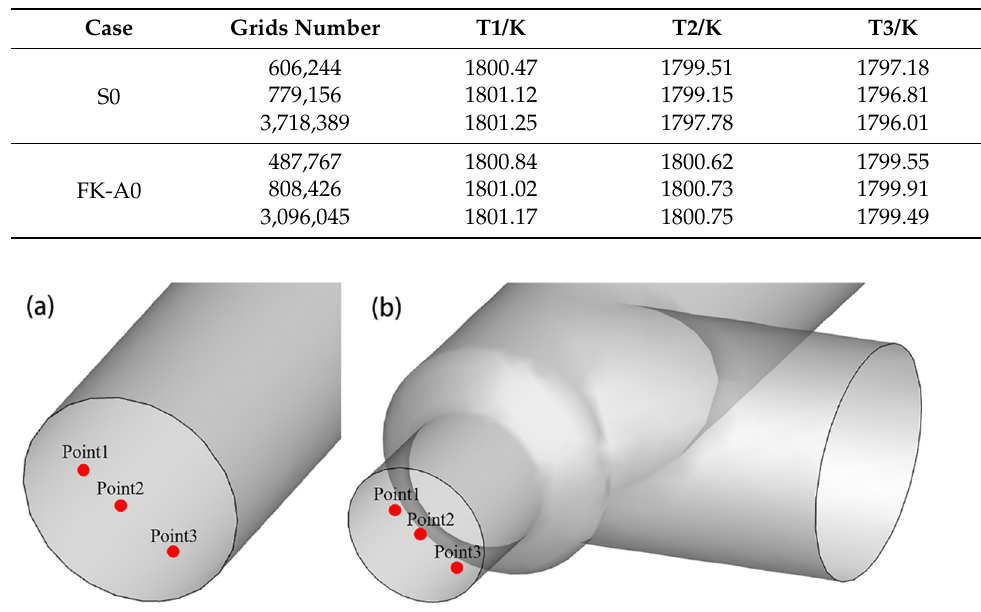
Figure 5. Location of the reference point: ( a ) channel exit section for S0 case; ( b ) “Channel out1” section for FK-A0 case. Table 4. Temperature of reference points with different grid numbers.